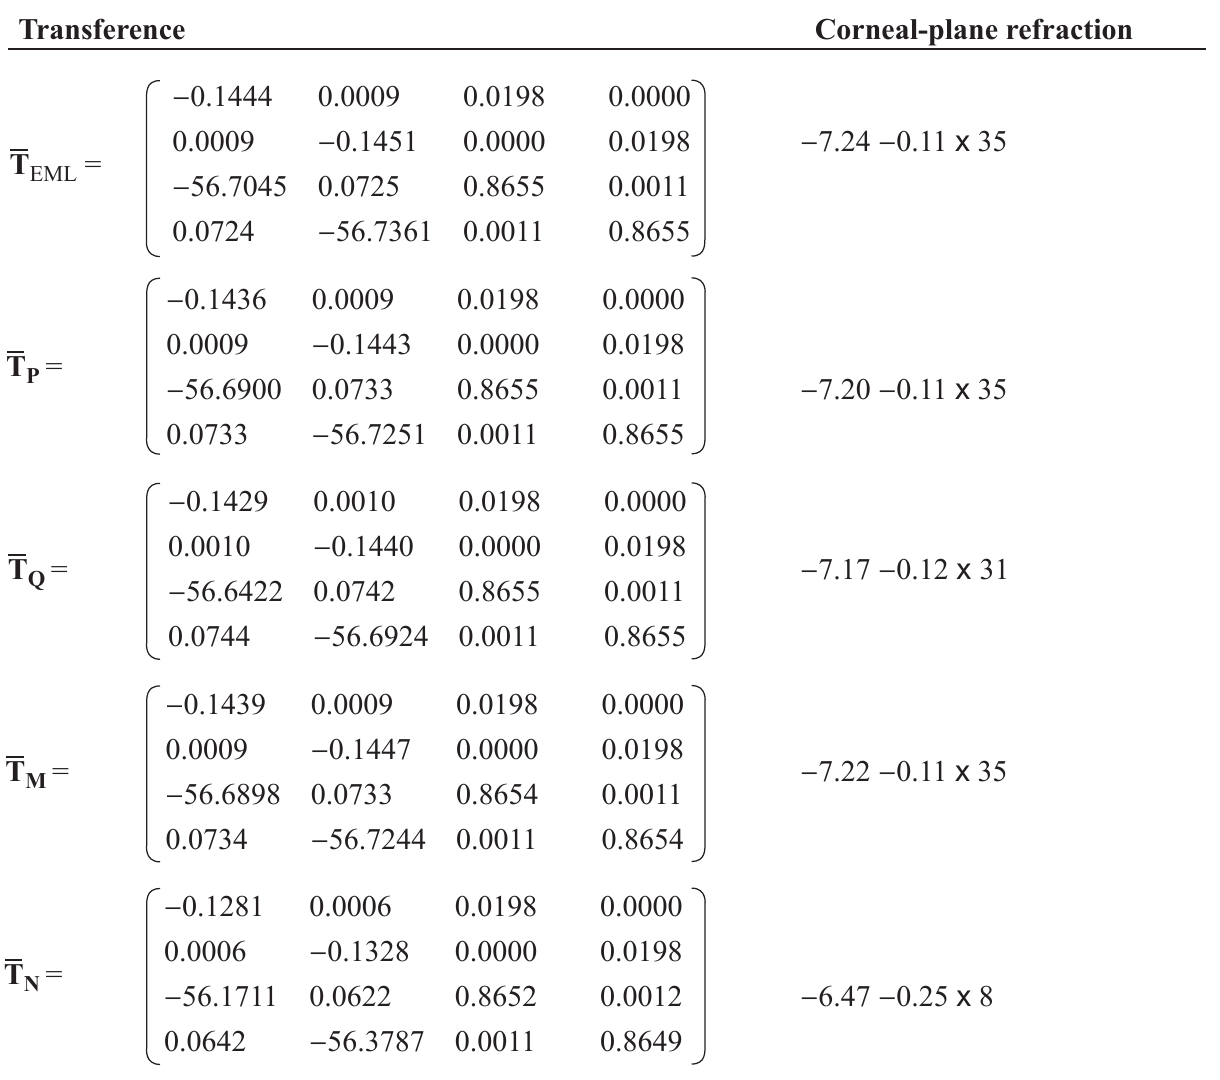
Table 2 The transferences of five different types of average eye calculated for the sample of 30 eyes partially listed in Table 1. The fifth row and fifth column of each transference are trivial and omitted. The corneal - plane refraction is given in each case for